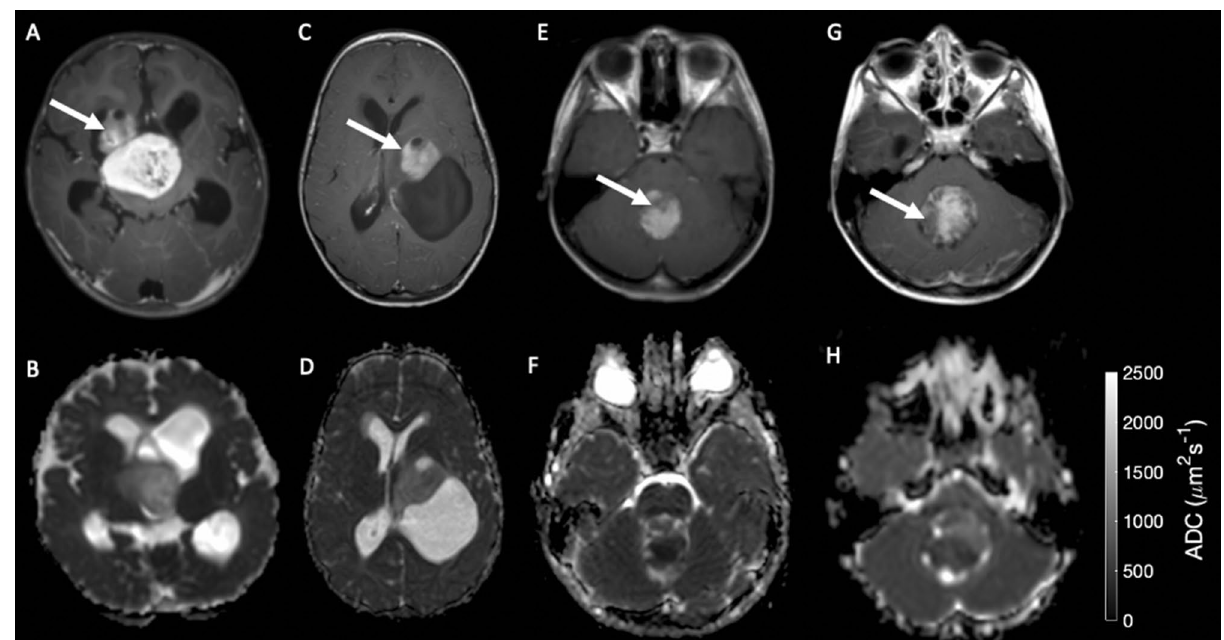
Figure 4. Example high and low risk, high and low-grade tumors. ( A T1 post contrast & B ADC map) high risk and ( C T1 post contrast & D ADC map) low risk Pilocytic astrocytoma, respectively showing elevated ADC skew and kurtosis in the tumor region. ( E , F ) high risk and ( G , H ) low risk medulloblastomas, respectively, showing increased ADC kurtosis. Tumor regions are highlighted with white